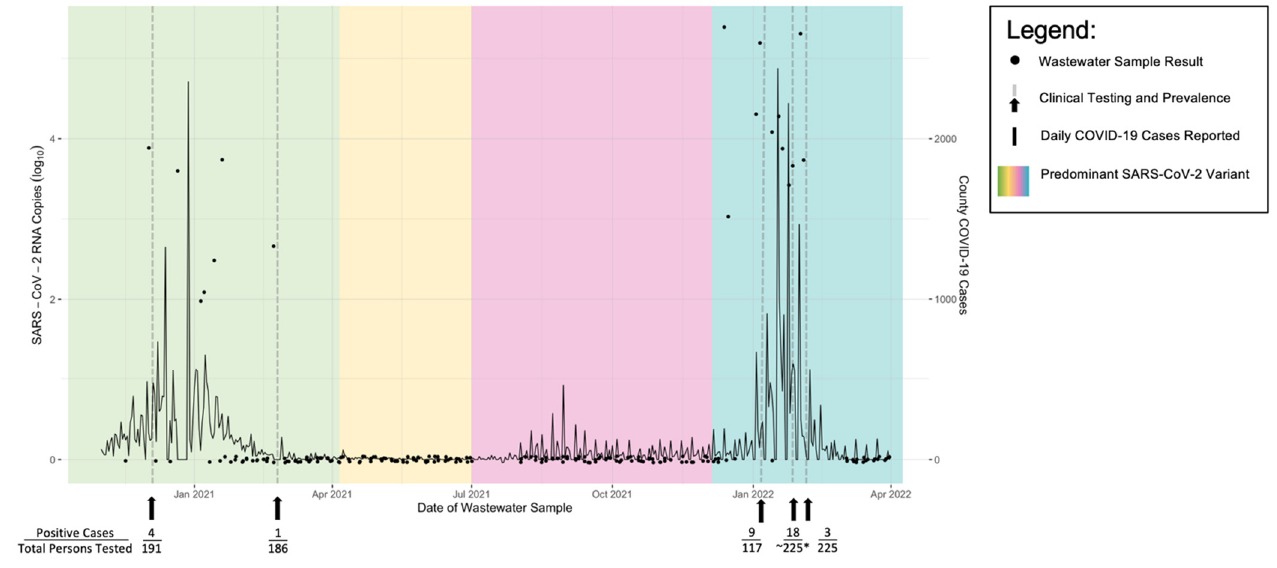
Figure 2. Wastewater Tested for SARS-CoV-2 N1 RNA in an Arizona Food Processing Facility, Nov 2020-Mar 2022. Wastewater samples were collected from a food processing facility’s waste basin and tested for SARS-CoV-2 N1 RNA between November 2020 and March 2022 ( n = 205). During the testing period, 18 unique dates had positive detections for SARS-CoV-2. All results were communicated with facility management and in the event of a positive signal, public health response was conducted the agriculture processing plant, among border health, and public health personnel. Signals which led to clinical testing ( n = 5) consistently identified SARS-CoV-2 positive employees. Dotted lines imbedded in the figure and arrows located below the figure indicate clinical antigen testing with the associated employees tested and number of positive detections below. COVID-19 cases reported to Yuma, Arizona are illustrated as a line graph to provide context regarding the COVID-19 activity in the surrounding community (data provided by USAFacts). Estimated predominantly circulating SARS-CoV-2 strain are reflected by background color panels: green, Wild-type; yellow, Alpha; pink, Delta; blue, Omicron. * Documentation of total individuals tested on 6 January 2022 was compromised and the denominator is an approximation.